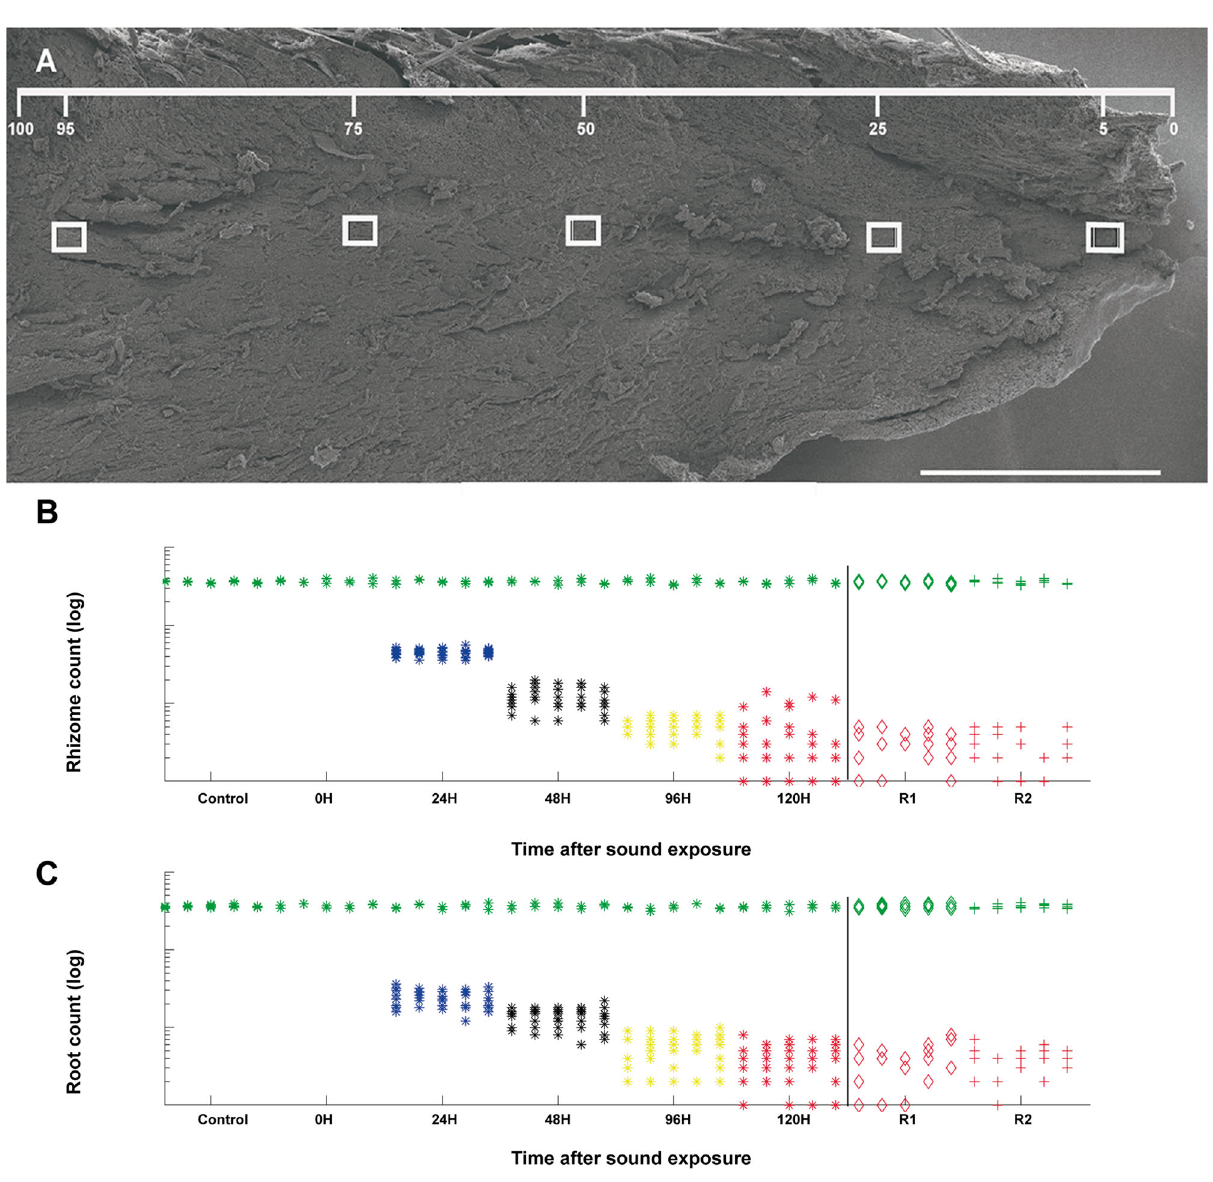
Fig. 4 Count locations on the P. oceanica rhizome. Starch grain count of the rhizome and root samples. A Count locations on the P. oceanica rhizome. Starch grain counts were sampled at fi ve predetermined locations: 5%, 25%, 50%, 75%, and 95% of the total sampling zone length. A In all, 0.09-mm 2 (300 × 300 μ m) box was placed at each sampling area, and starch grains were counted within each box. Scale bar = 3 mm. B , C Results of the starch grain count of the rhizome samples (B) and root samples (C). The left part shows the results of the initial experiments. PRE counts were taken from samples that were fi xed immediately after plants arrived in the laboratory. At 0H, the sound exposure started and a control sample was taken before exposure. At each further sampling moment, two control samples were taken together with exposed samples. R1 and R2 are the two replicates (control in green) at 120 h after exposure (in red). The y-axis is shown in logarithmic scale to reduce the order-of-magnitude difference between control and exposed samples. For the exposed samples, the counts are organized per sampling time (hours after exposure) and within each sampling time per sampled area (5 – 95%). For the control samples, all sampling times were combined together and the samples are separated per sampled